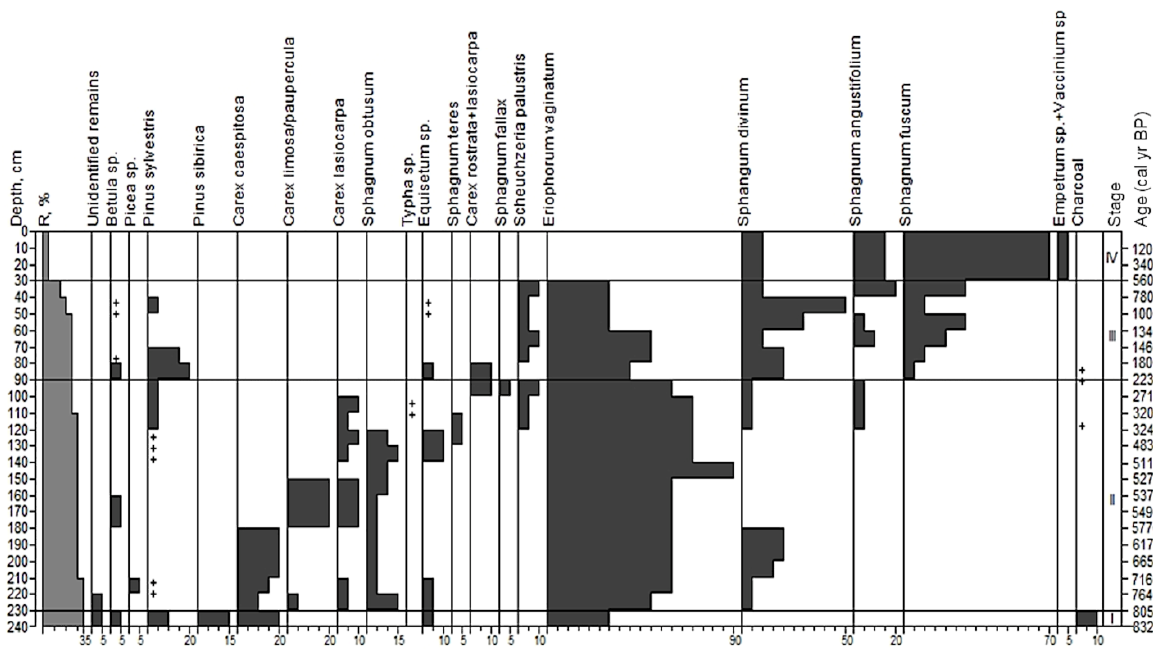
Figure 8. Macrofossil diagram for site 5. Stages correspond to paleo-communities: ( I ) — Pinus + Betula - herbaceous- Sphagnum ; ( II ) — herbaceous+ Eriophorum vaginatum-Sphagnum spp.; ( III ) — Pinus syl- vestris-Eriophorum vaginatum-Sphagnum spp.; ( IV ) — Ericales- Sphagnum fuscum ; + — abundance less than